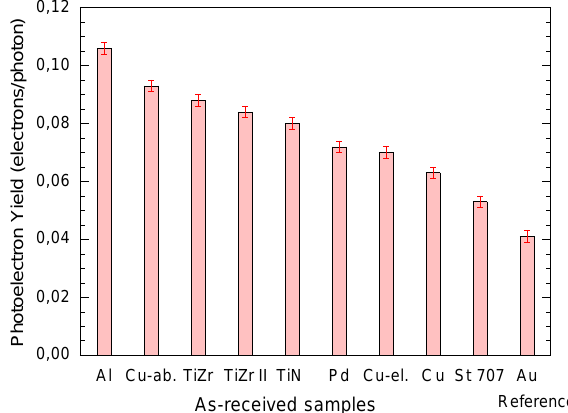
FIG. 13. (Color) The plot showing the PY during WL illumina- tion, sorted as a function of decreasing values, for the different as-received samples.